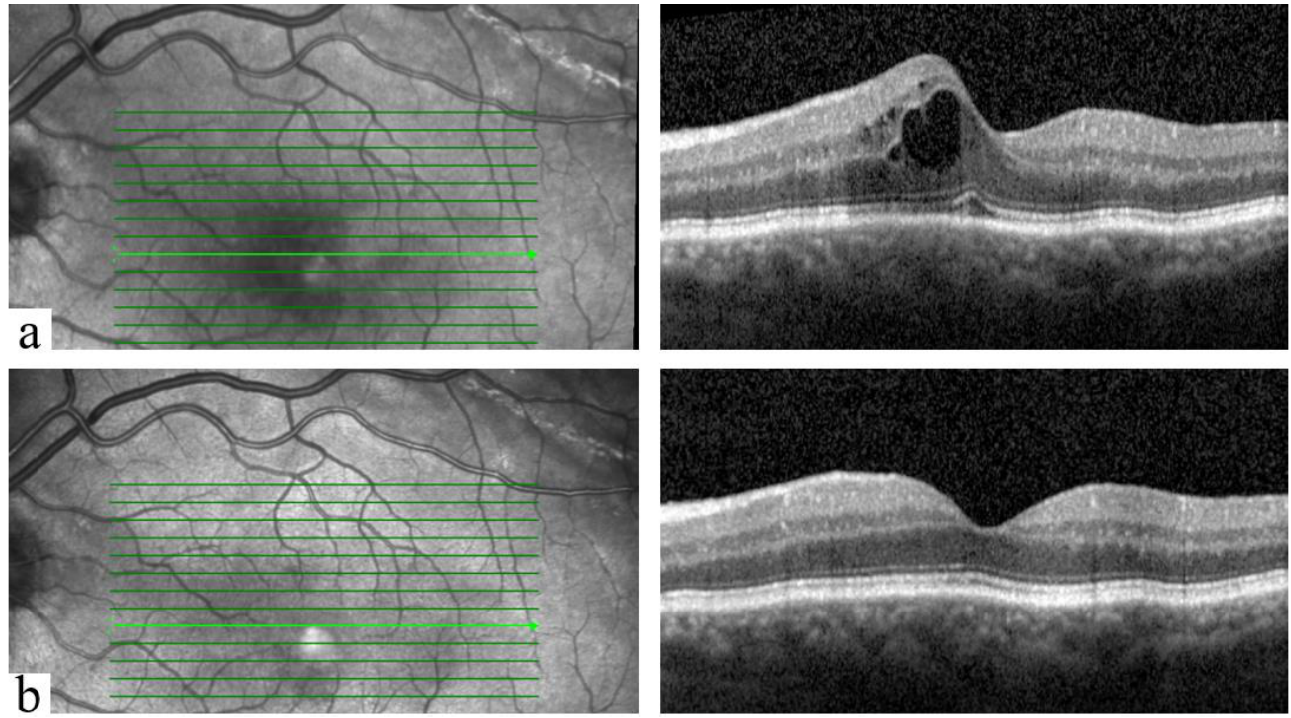
Figure 2. An example of OCT findings of an included patient of group 1 (male, 69 years old): ( a ) At the diagnosis of PCME. Central macular thickness (CMT) was 425 µm. ( b ) After treatment with once daily NSAIDs eye drops (nepafenac 3 mg/mL; Nevanac ® ) and oral acetazolamide (Glaupax ® 250 mg). CMT was 311 µm. PCME occurred 33 days postoperatively and resolved at the first follow-up after 28 days. Table 4. The analysis of patient-related, ocular or intraoperative possible risk factors for non-re- sponse to therapy with NSAID eye drops and acetazolamide.